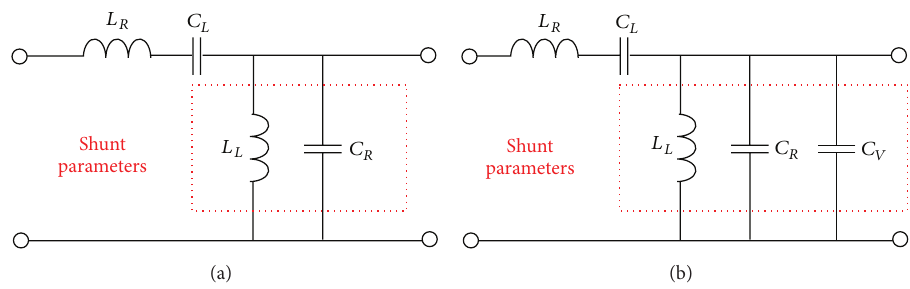
Figure 1: Equivalent circuit model. (a) General CRLH TL unit cell. (b) CRLH TL unit cell with slot and additional capacitor.